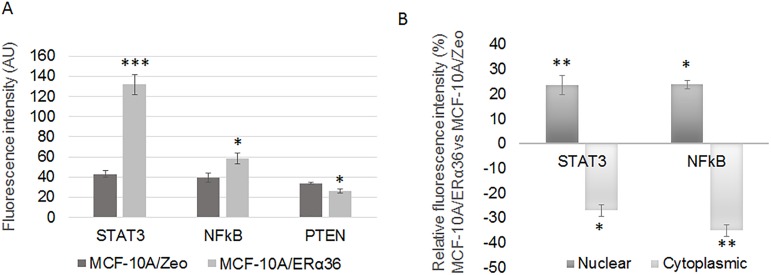
ERα36 overexpression modulates MAPK/ERK1/2, NFkB and JAK2/STAT3 signaling pathways in MCF-10A cells.Expression levels of PTEN, Phospho-ERK1/2 (P-Erk), NFκB and STAT3 were measured by immunofluorescence with specific antibodies: anti-PTEN, anti-Phospho-ERK1/2, anti-NFκB p65, anti-STAT3 in MCF-10A/Zeo and MCF-10A/ERα36 cells. Total, nuclear and cytoplasmic average fluorescent signal intensities (AlexaFluor 555) are quantified from 5 cells in at least 5 separate fields per condition. Each bar represents mean ± S.E.M. N = 3 independent experiments. *: P<0.05, ***: P <0.001. A. Average fluorescence of PTEN, Phospho-ERK1/2, NFκB and STAT3 in whole MCF-10A/Zeo and MCF-10A/ERα36 cells. B. Ratios of nuclear or cytoplasmic average fluorescence of STAT3 and NFkB intensities in MCF-10A/ERα36 versus MCF-10A/Zeo cells indicating nuclear relocalization following ERα36 overexpression.